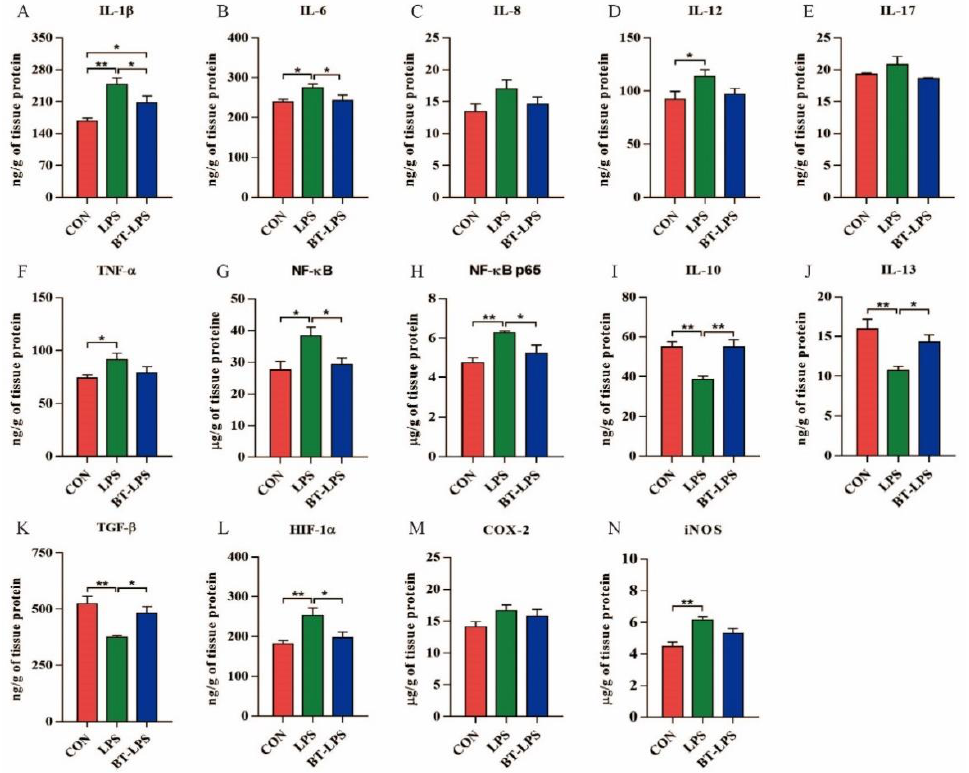
Figure 2. The effects of butyrate on LPS-induced jejunal inflammation. (A – H) The pro-inflammatory associated cytokine IL- 1β, IL -6, IL-8, IL-12, IL-17, and TNF- α levels; (I – K) The anti-inflammatory cytokine IL-10, IL-13, and TGF- β levels; (G, H) The transcription factor NF- κB and NF- κB p65 levels; and (L – N) HIF- 1α, COX -2, and iNOS levels in LPS-induced jejunum. Values are the mean ± standard error ( n = 6). * p < 0.05 and ** p < 0.01. error ( n = 6). * p < 0.05 and ** p <